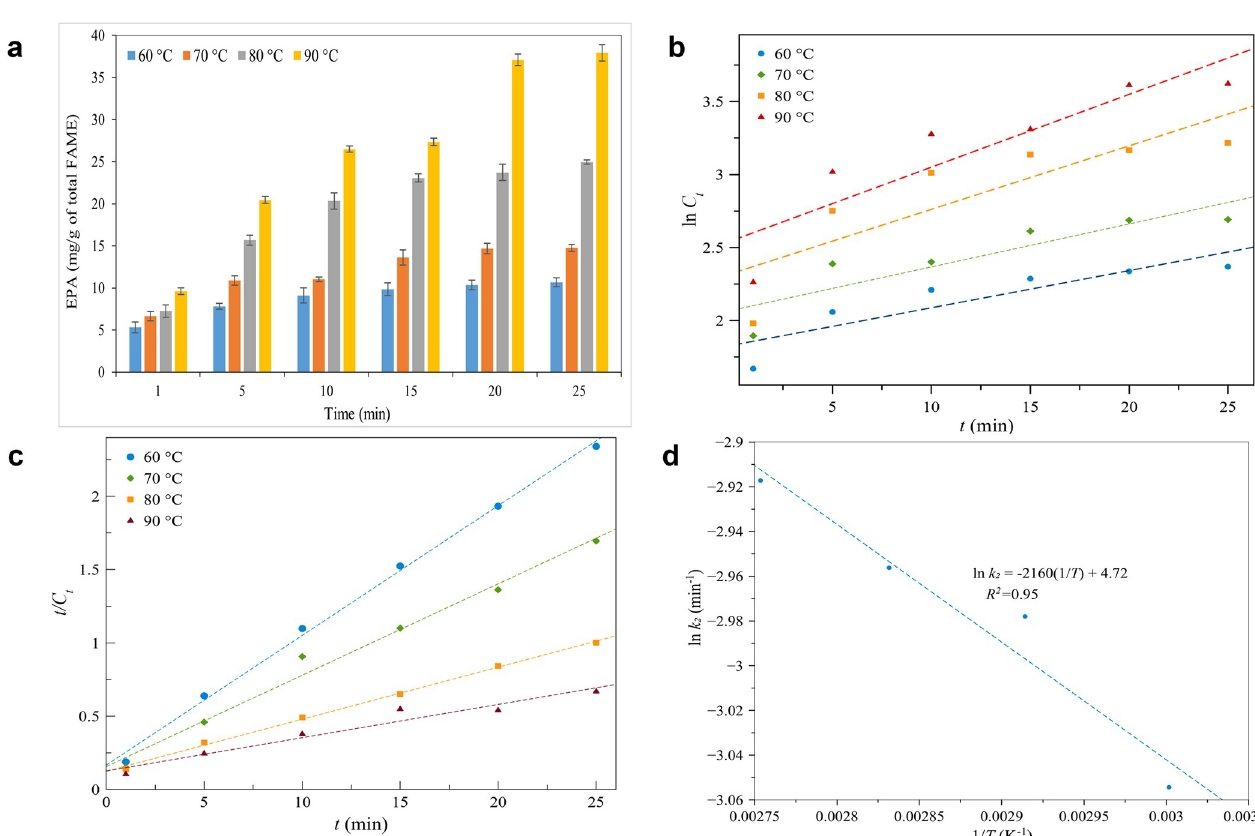
Fig 3. (a) Kinetic extraction of EPA (mg g -1 FAMEs ) from N . oceanica in MAILE using 1.65 g of [TMAm][Cl] at temperature range: 60 to 90˚C for 1–25 min, (b) First-order rate law kinetic model of EPA extraction, (c) Second-order rate law kinetic model of EPA extraction, and (d) Relationship between the temperature and second-order rate constant (ln k 2 ). Each experiment was repeated threefold and the values are stated as means ± standard deviations. The error bars represent standard